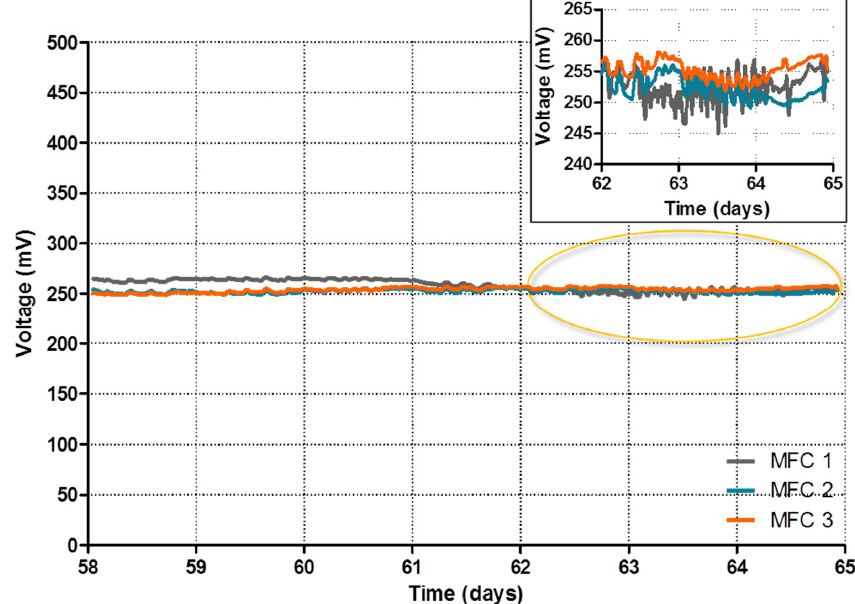
Figure 5. Stable power generation over seven days, from triplicate MFCs under metabolic steady state. Inset graph presents a magnified view of the highlighted period.